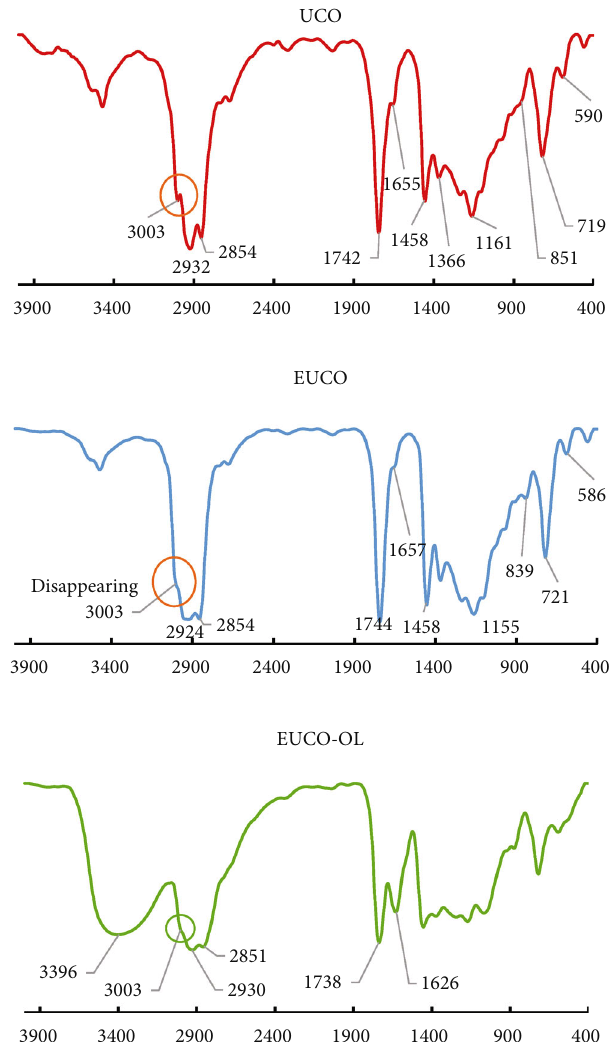
Figure 7: UCO, EUCO, and EUCO-OL FTIR